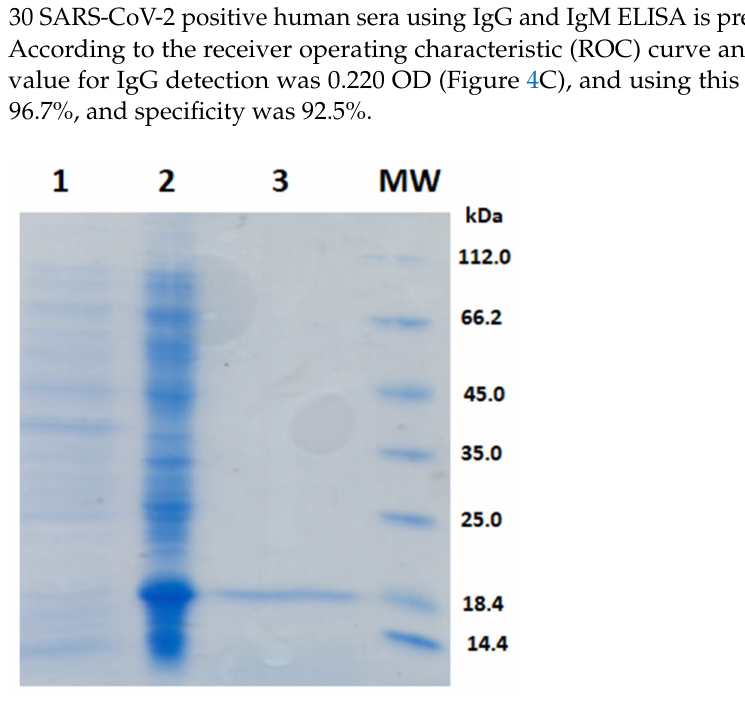
Figure 2. SDS-PAGE of the recombinant M protein: Samples were separated on 14% SAS-PAGE, after which the gel was stained with CBB R 250. Lines: MW) molecular weight markers; (1) cell lysate before the addition of IPTG, (2) cell lysate after 6 h of expression, (3) purified M protein after IMAC.